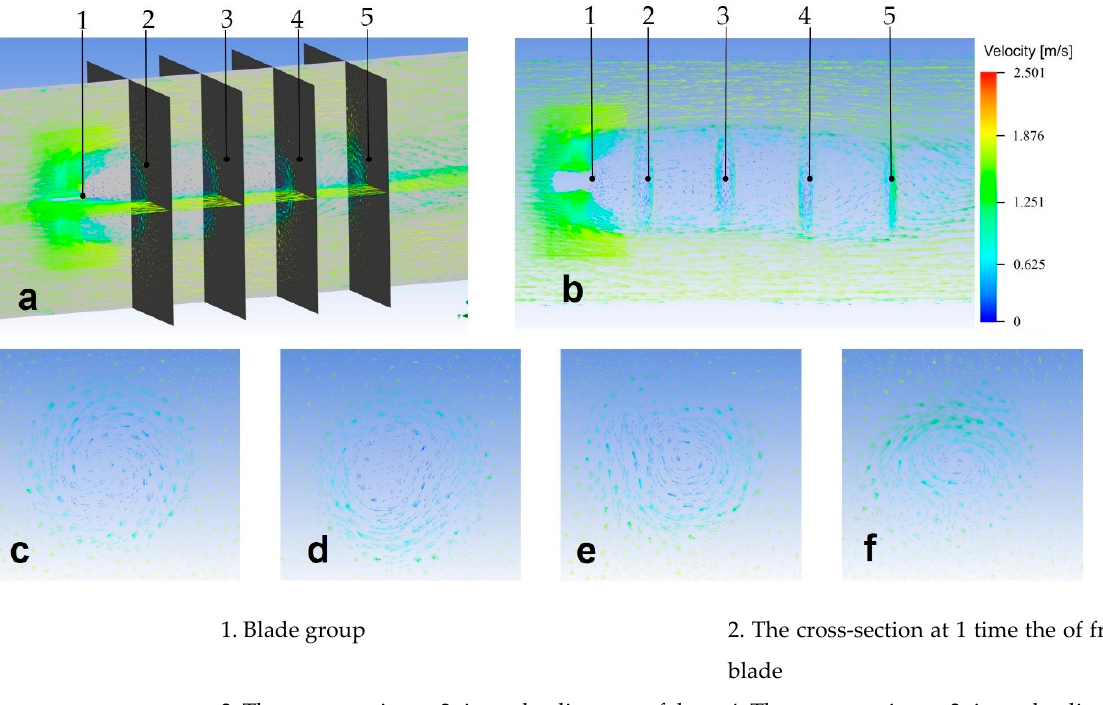
Figure 11. Wake field vector of the passive morphing blade: ( a ) section in the wake field; ( b ) wake field vector; ( c ) vector in cross—Section 2; ( d ) vector in cross—Section 3; ( e ) vector in cross—Section 4; ( f ) vector in cross—Section